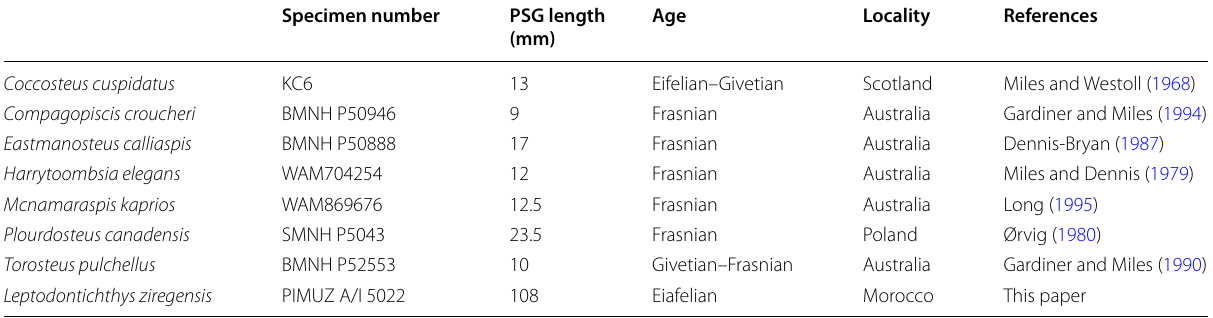
Table 4 Eubrachythoracid posterior superognathals used in this